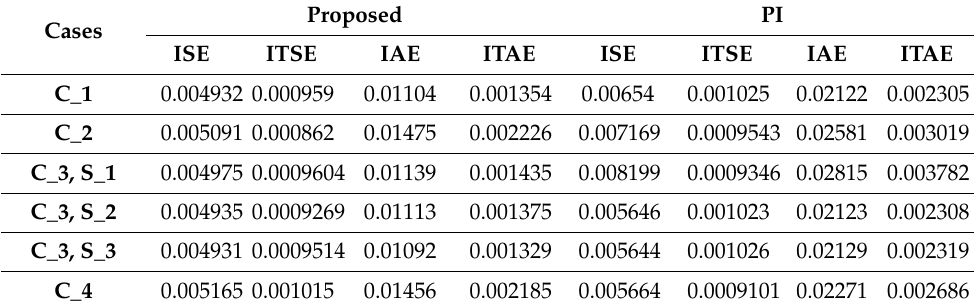
Table 1. Control performances under balanced grid conditions. C—Case,